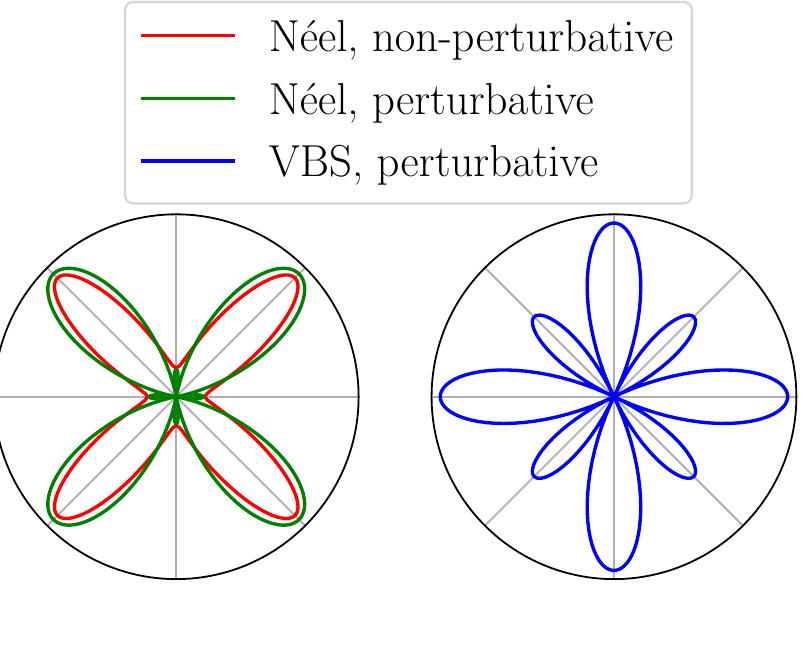
Figure 6 . Plotted are the angular profiles of the equal-time Néel and VBS correlation functions in real space, at the fixed point value of velocity anisotropy Φ . The Néel order parameter shows c enhanced correlations along the diagonals, whereas the VBS correlations are more enhanced along the x and y directions. Note that we only plot the absolute value of the correlation function, and the signs of the perturbative Néel and VBS correlators flip when moving from the x and y axes to the diagonals. As this feature is not present in the non-perturbative Néel correlator, it is possible that this feature similarly vanishes at higher orders for the VBS